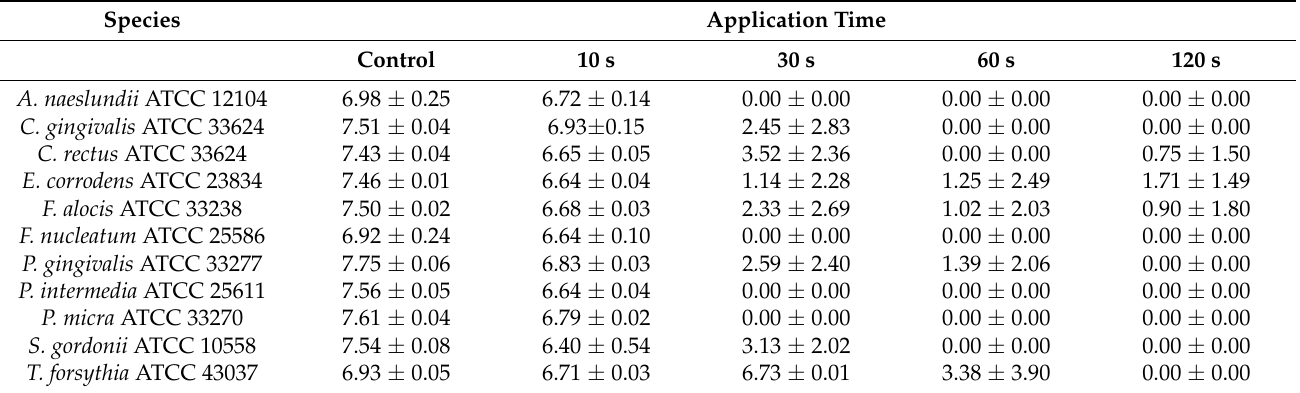
Table 1. Colony forming units (log 10 ; means ± standard deviation) of planktonic bacteria before and after application of cold plasma for 10, 30, 60, and 120